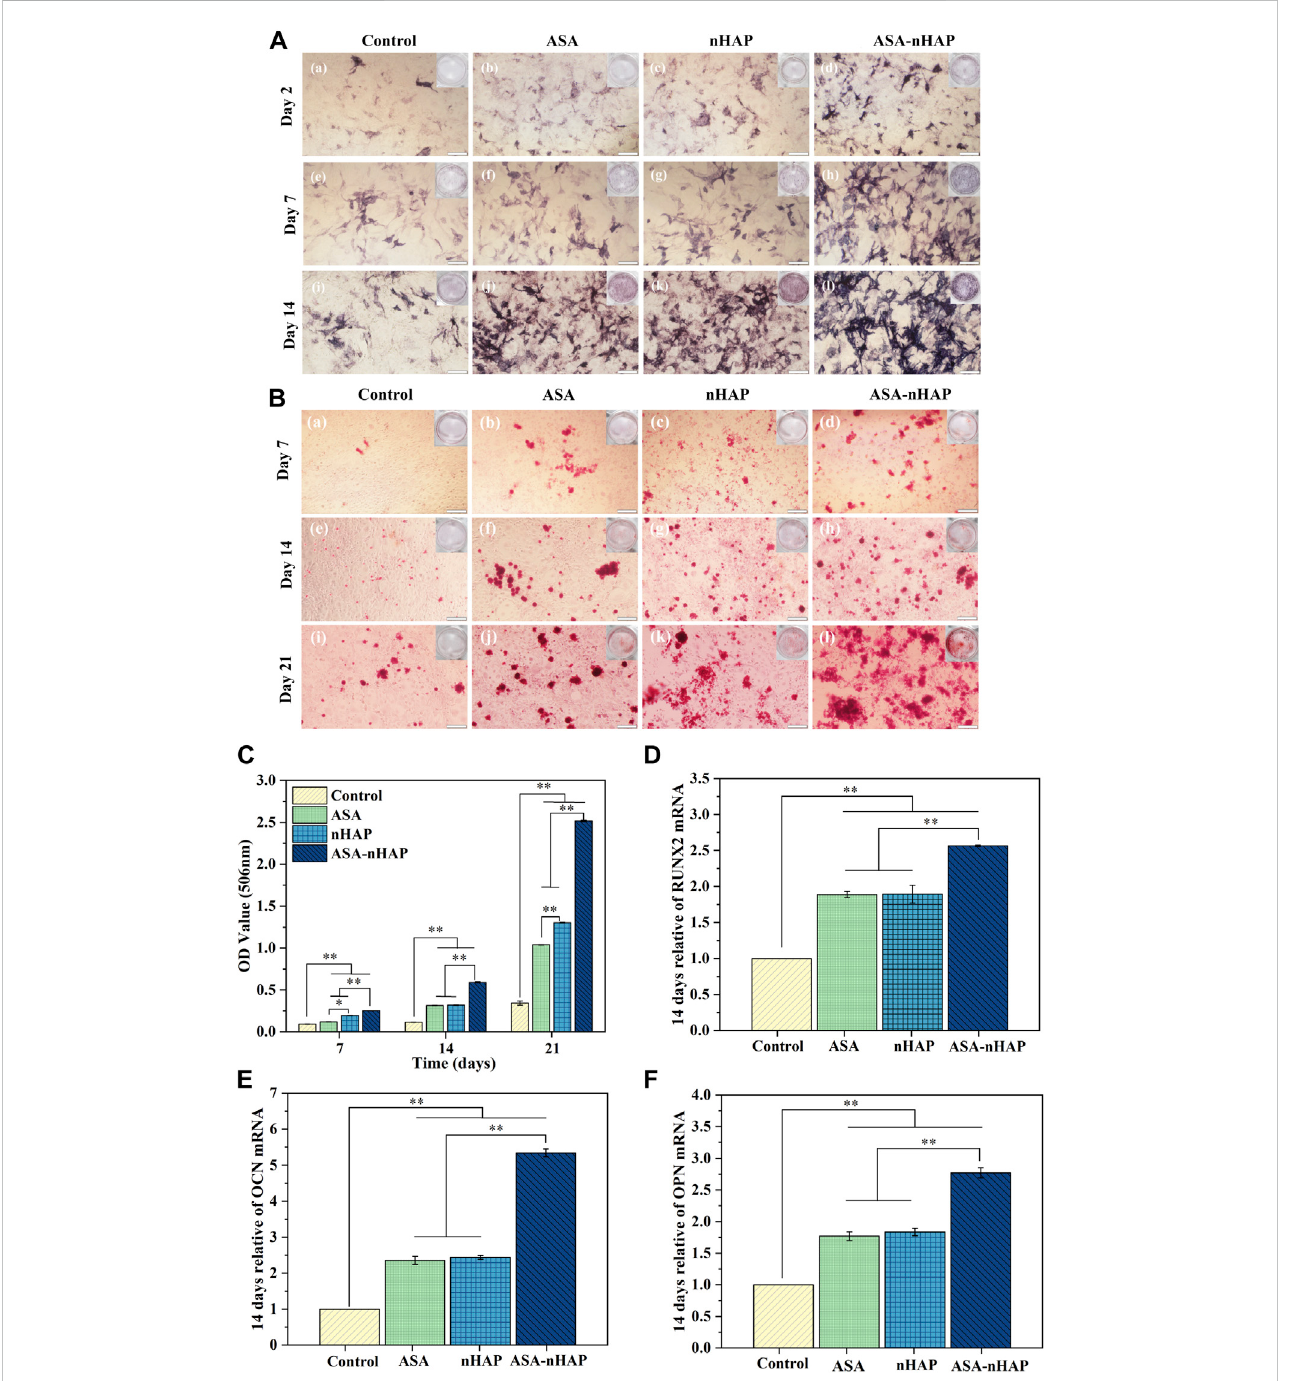
FIGURE 5 Osteogenic differentiation ability of MC3T3-E1 cells cultured in vitro . (A) Digital and microscopic images of MC3T3-E1 cells in the control group, ASA group, nHAP group, and ASA-nHAP group after 2, 7, and 14 days to assess ALP activity, thescale baris 200 μ m. (B) Digital and microscopicimagesofMC3T3- E1 cells in the control group, ASA group, nHAP group, and ASA-nHAP group after 7, 14, and 21 days to assess the expression of calcium nodules, scale bar is 200 μ m. (C) Semi-quantitative analysis of the expression of calcium nodules in thecontrol group, ASA group, nHAP group, and ASA-nHAP group after 7, 14, and 21 days (** p < 0.01). (D – F) Expression of osteogenic genes of RUNX2, OCN, and OPN after 14 days (** p <